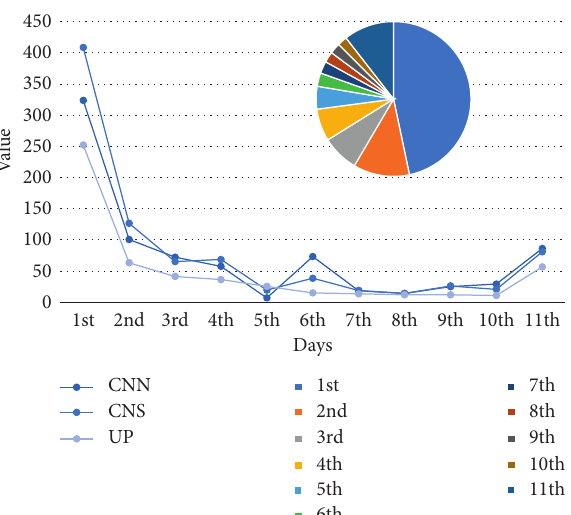
Figure 8: Comparison of backtesting between the CNN and tra- ditional methods in a specific time